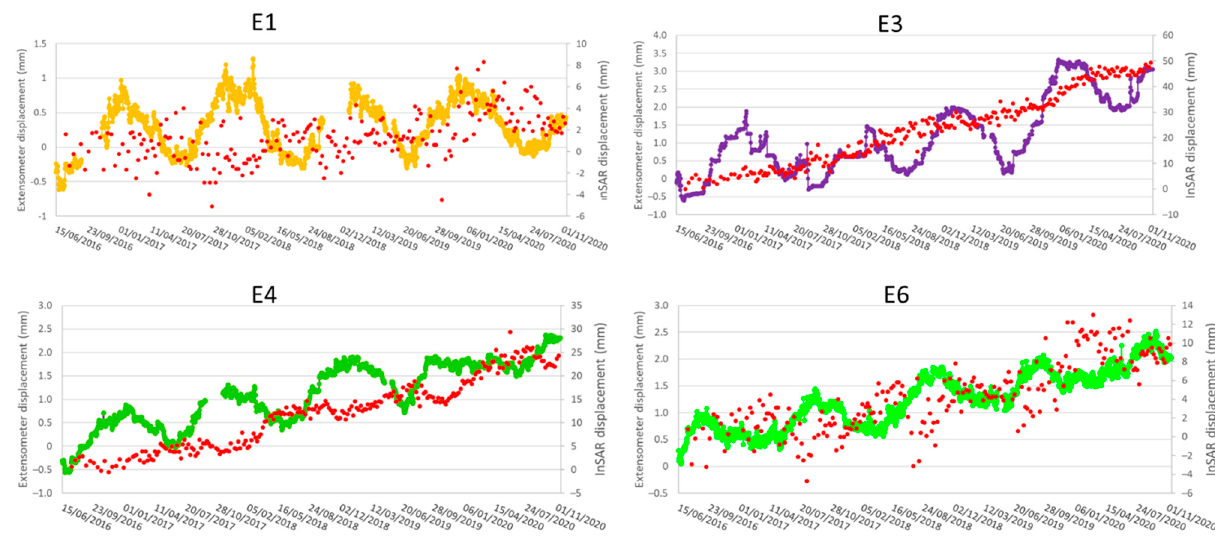
Figure 13. Four examples of comparison between deformations measured by bar extensometers (E1, E3, E4 and E6, colored lines) and PSI located close to the extensometer (red dots).